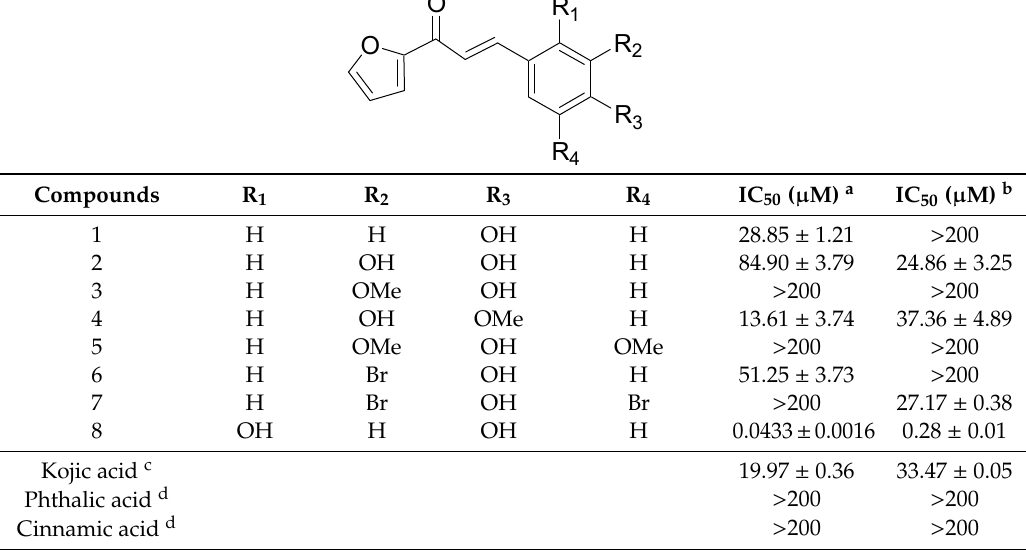
The 50% inhibition concentration (IC 50 ) values (µM) were calculated from a dose-response inhibition Compounds curve using L -tyrosine a and L -3,4-dihydroxyphenyl-alanine ( L -DOPA b ) as substrates, respectively, and are shown as means ± SEM of triplicate experiments. c Reported competitive-type inhibitor. d Reported mixed-type inhibitor.